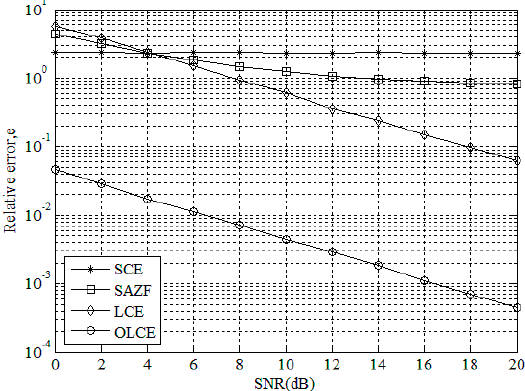
Figure 4. Relative error e of channel estimation for SCE, SAZE, LCE, and OLCE when the number of collided tags is three and SNR ranges from 0 to 20 dB.